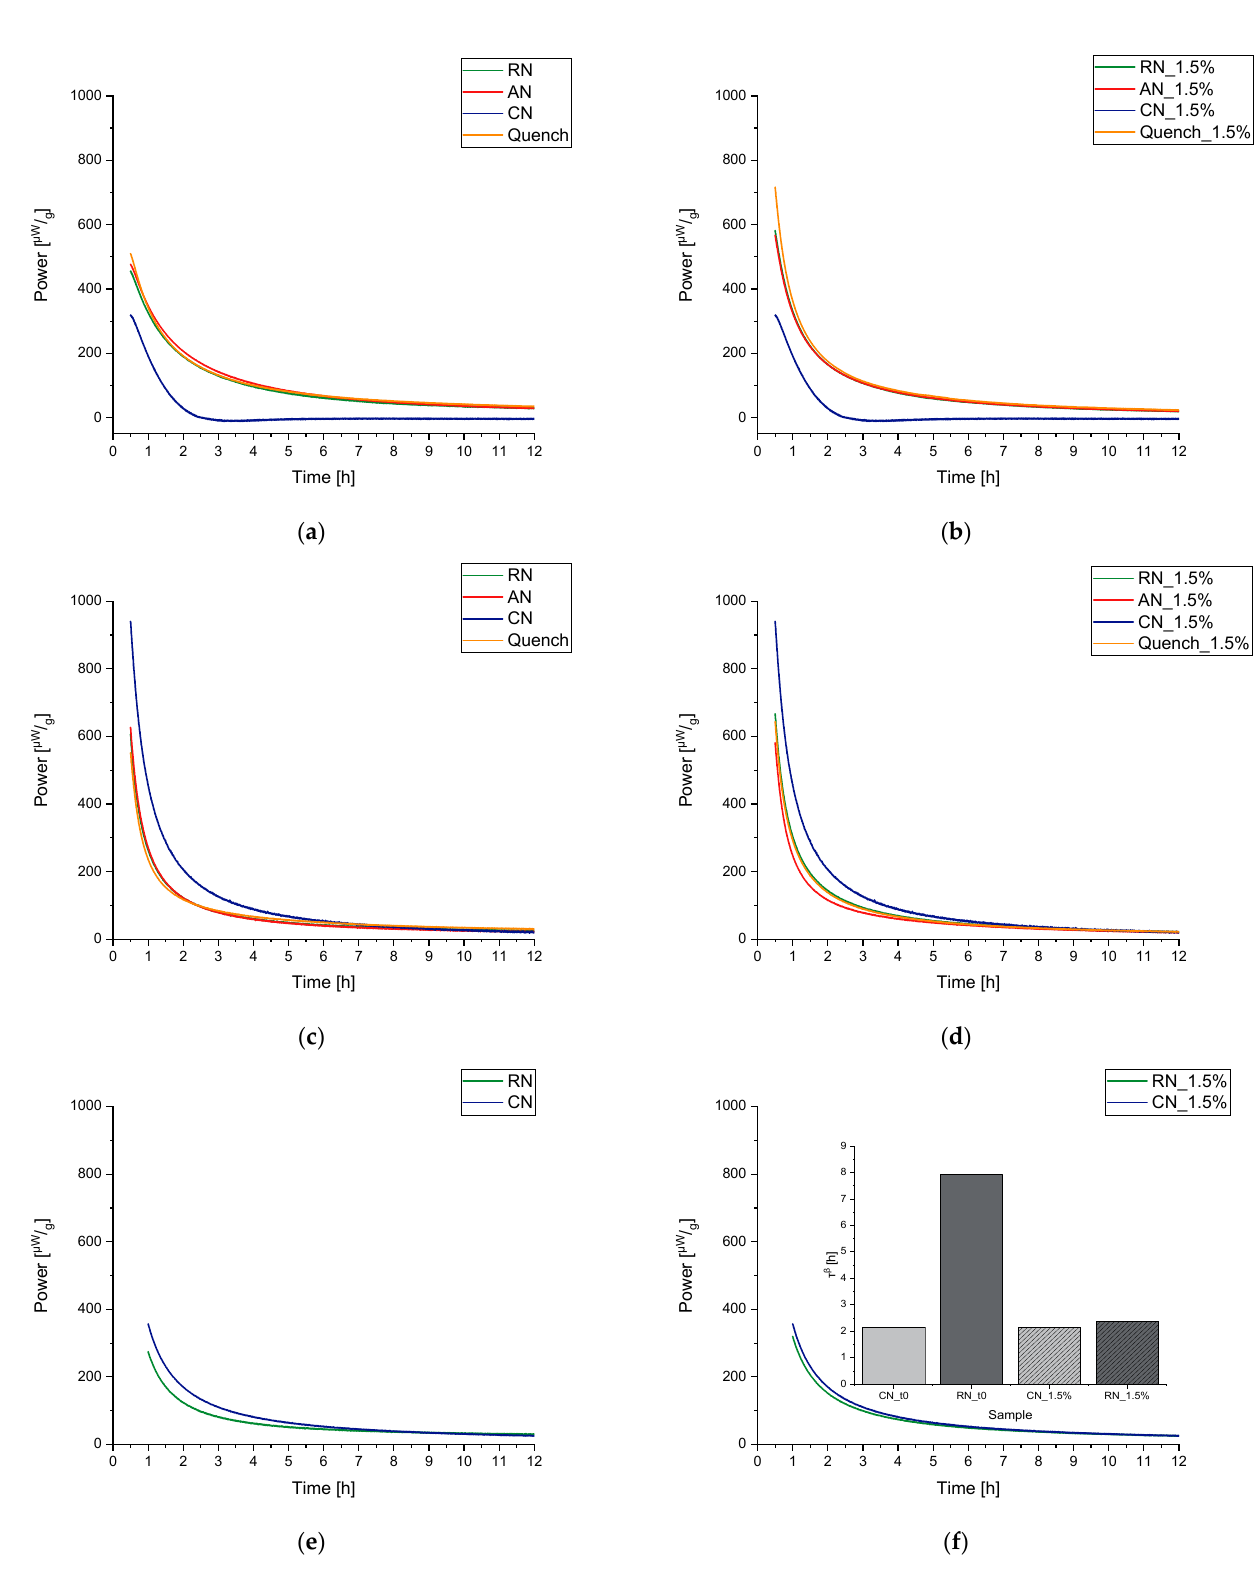
Figure 12. Relaxation curves of samples with different freezing processes but same compositions. ( a , b ) Sucrose-based formulations measured at 40 °C, ( c , d ) trehalose-based formulations measured at 40 °C, ( e , f ) trehalose-based formulations measured at 55 °C. Samples in ( a , c , e ) were measured at t(0), whereas samples in ( b , d , f ) were adjusted to the same residual moisture of around 1.5%. The small diagram in ( f ) displays the respective τ β values of the corresponding samples in ( e , f ). At 55 °C, only CN and RN processes were compared. MSE